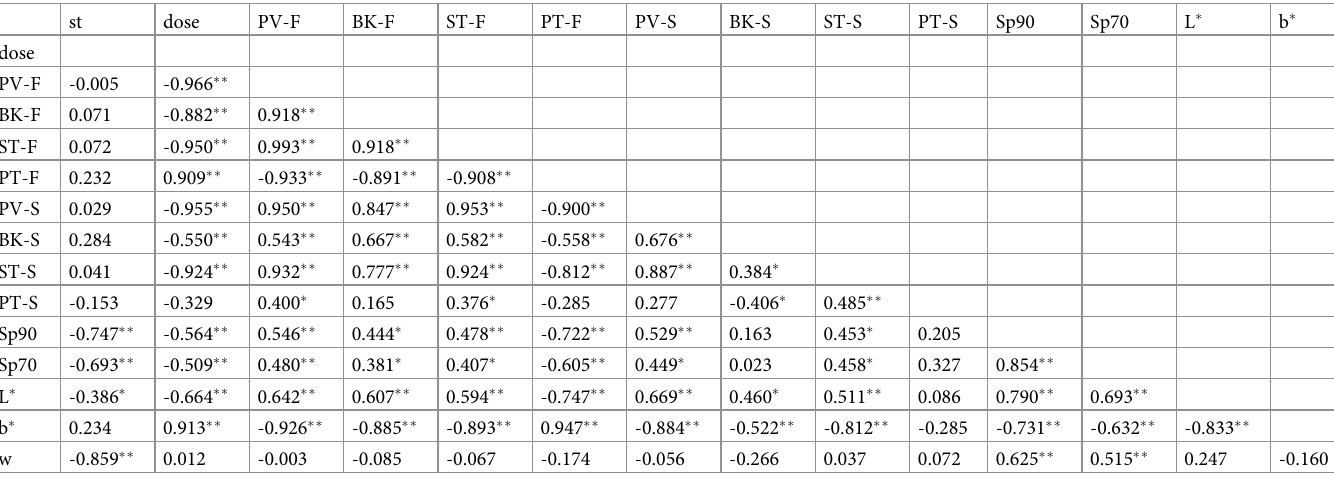
Table 6. Correlation coefficients among various functional properties of the irradiated rice sample at 37 ˚C b